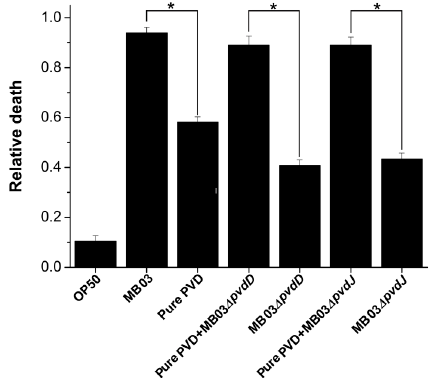
Figure 6. Nematocidal activity assay of P. syringae MB03 and the mutant strains MB03 ∆ pvdD and MB03 ∆ pvdJ , alone or with pure PVD: MB03 filtrate (MB03 grown in M9 which induce PVD production) showed noteworthy killing. The role of PVD in liquid killing (LK) assay was confirmed by attenuated virulence of both mutants (defective in PVD production). Pure PVD was added in the mutants to measure the relative death rate, which was comparable with the wild-type MB03. Mortality of worms in each well was determined in 4 days. Asterisks indicate a significant di ff erence between the selected two groups in a two tailed t test ( p value < 0.05). Three biological replicates were performed for each experiment. Error bars represent the standard deviations from the means of three independent experiments.